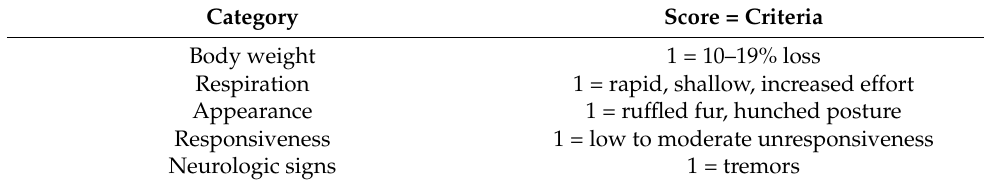
Table 1. Clinical scoring system used for clinical monitoring of SARS-CoV-2-infected K18-hACE2 mice. Category Score = Criteria Body weight 1 = 10–19% loss